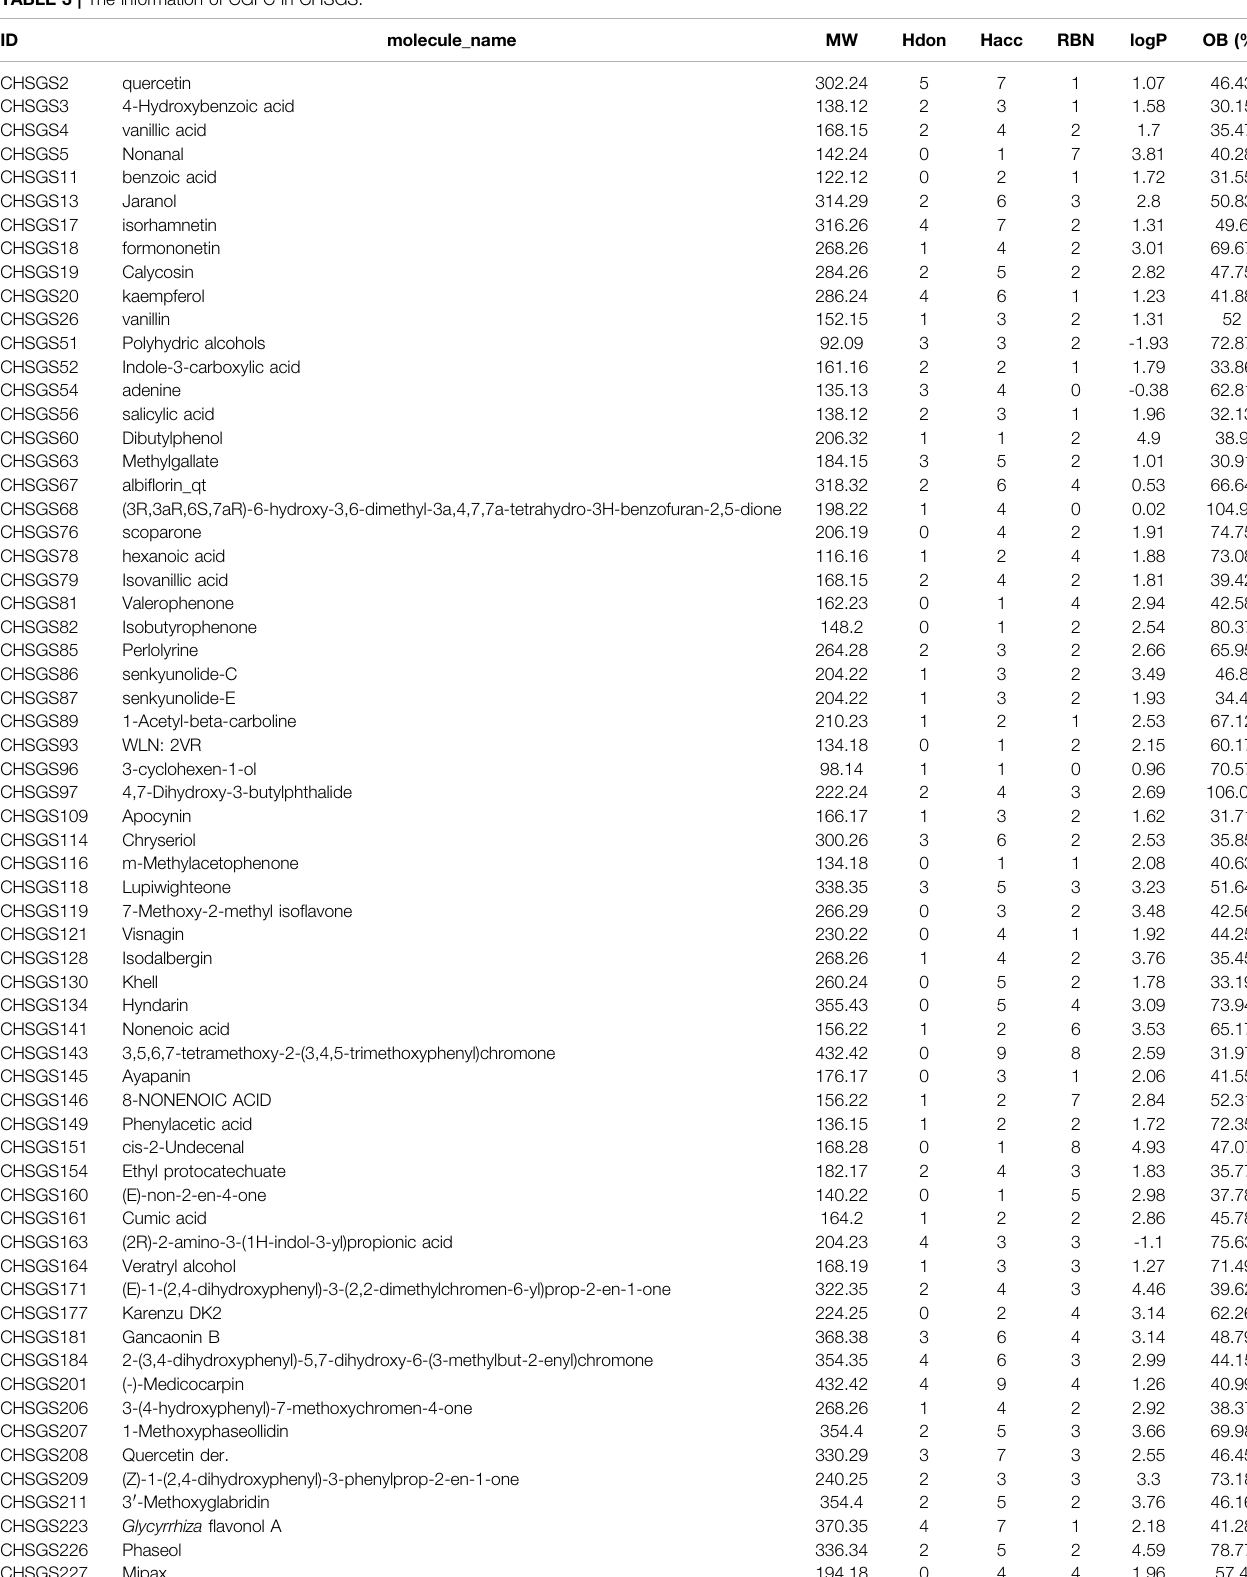
TABLE 3 | The information of CGFC in